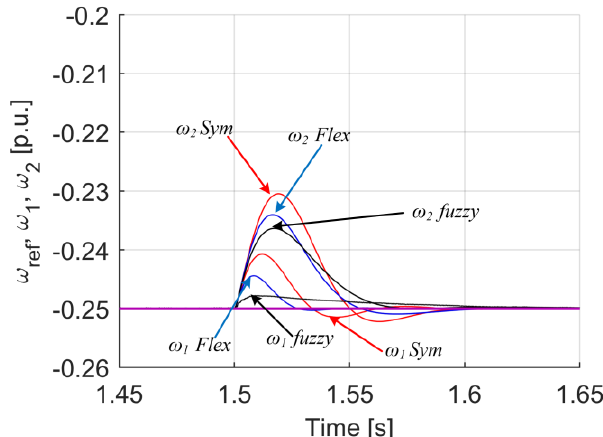
Figure 18. Transients of difference between motor and reference speed for analyzed controller cases.